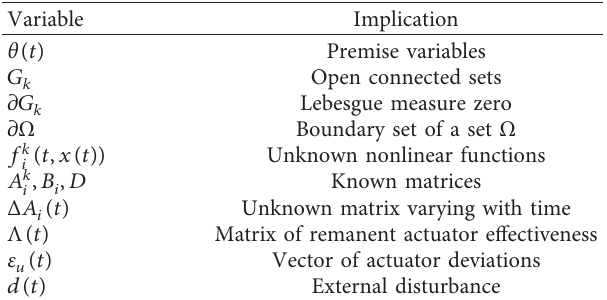
Table 1: The symbols used in the